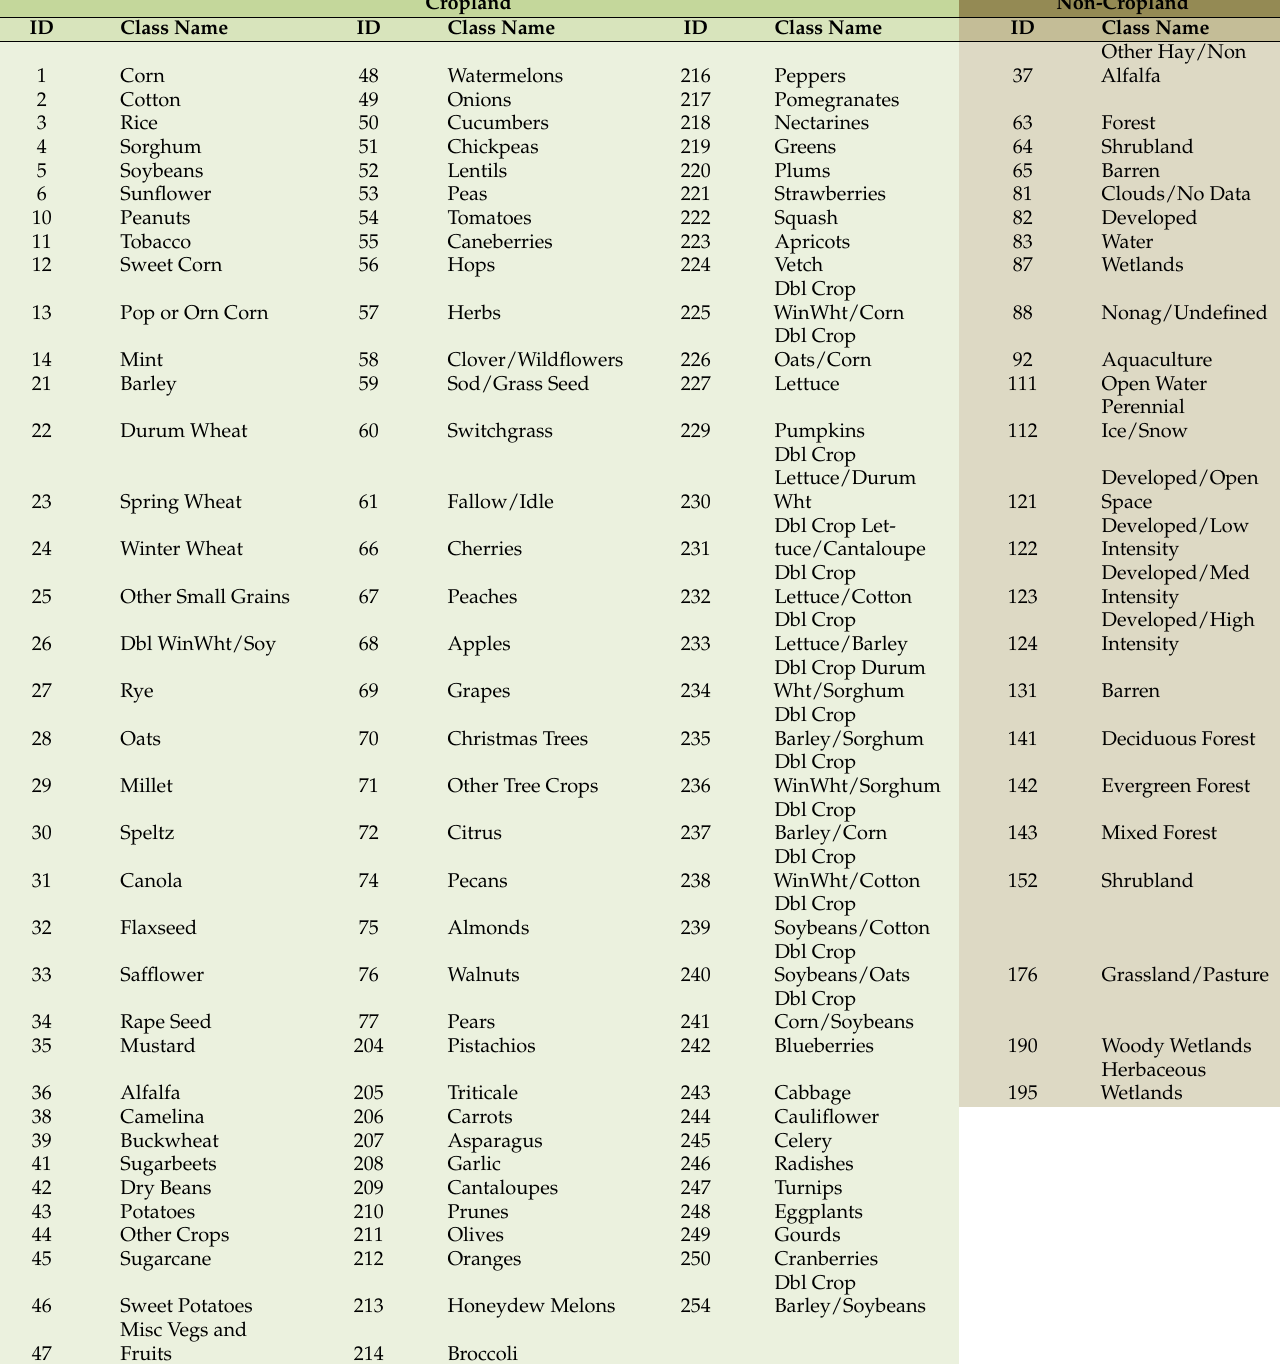
Table A1. List of CDL codes and class names and whether they were included in the cropland or non-cropland domain in the analyses of superclass and consolidated class accuracies. Domain delineations follow that of Lark et al. (2015) based on original NASS distinctions